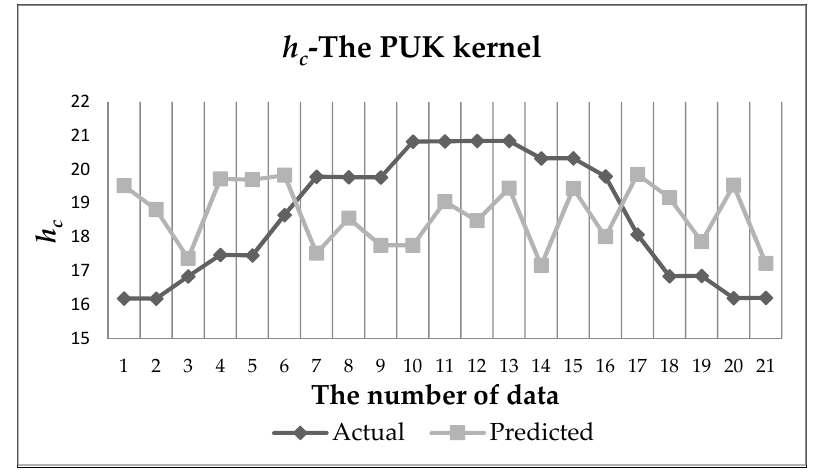
Figure 10. Actual and Predicted data of h c for Pearson VII (PUK) kernel.